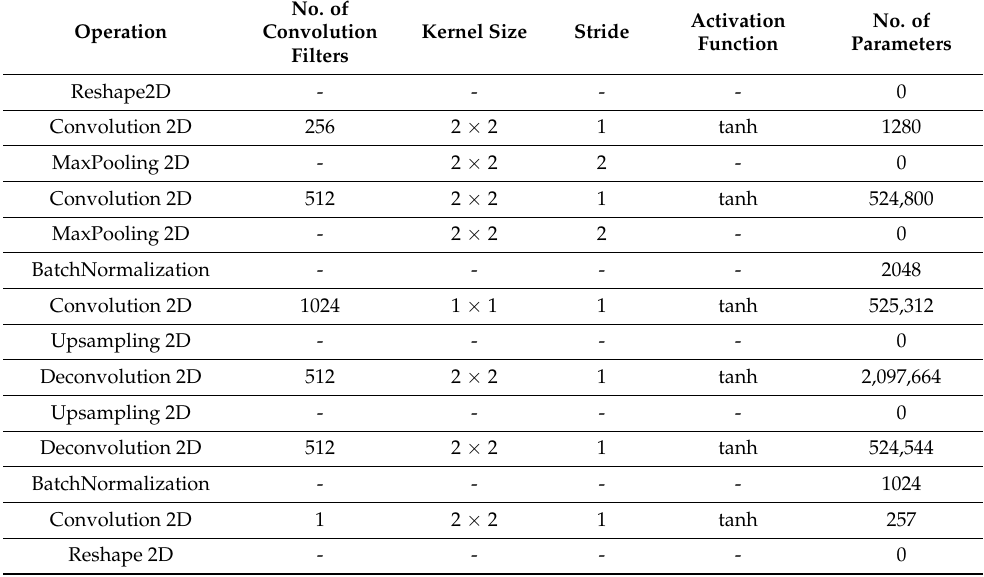
Table 3. Summary of the hyperparameters of the convolutional